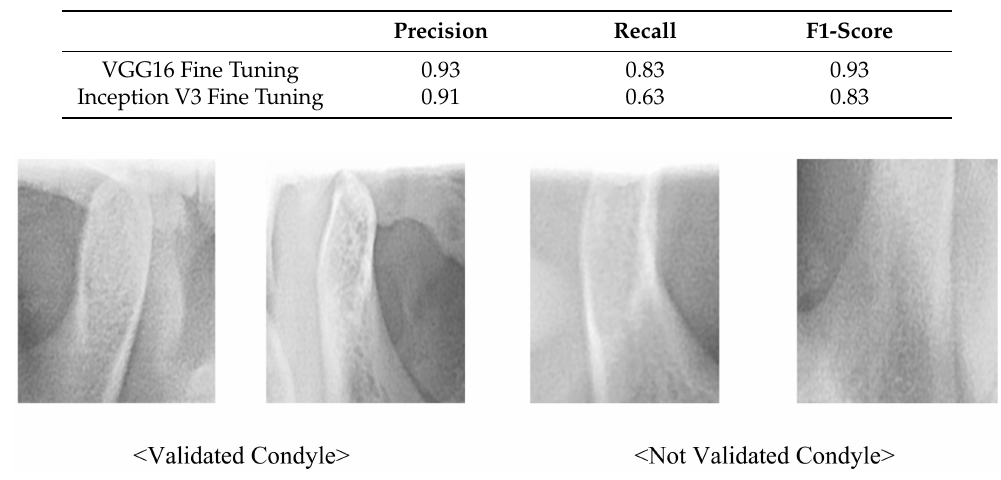
Table 3. Performance results of condyle validity.